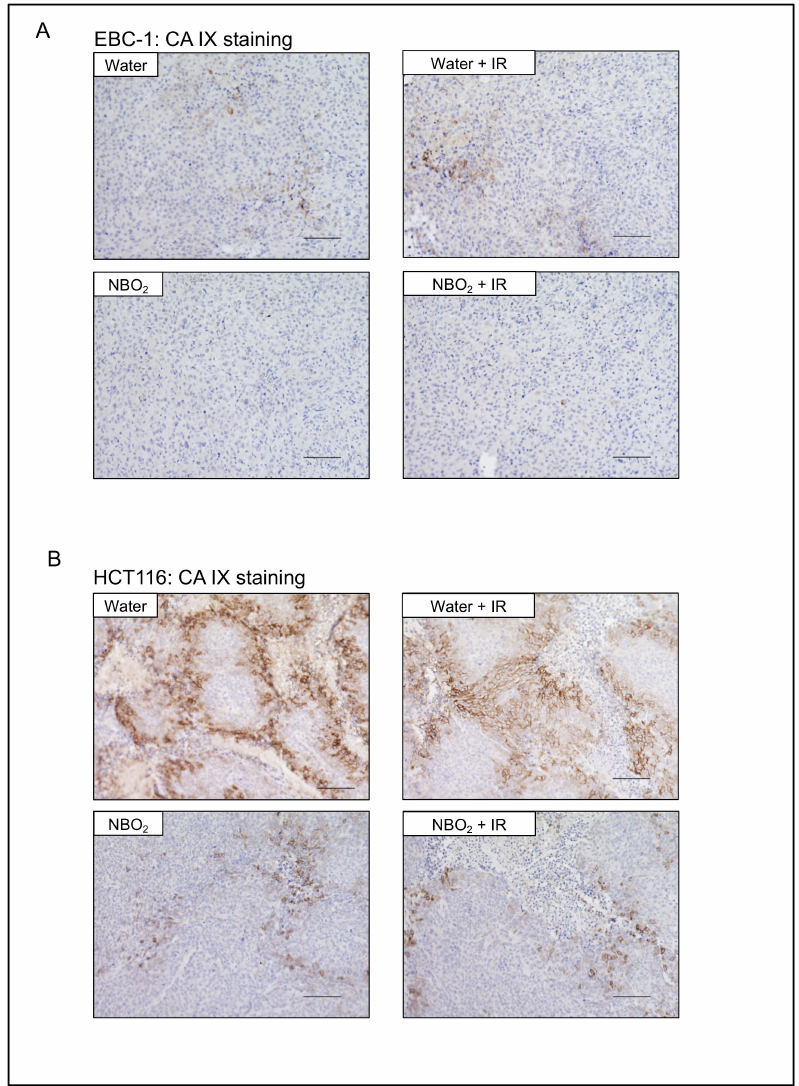
Figure 6. Hypoxia-related carbonic anhydrase IX (CA IX) expression in EBC-1 and HCT116 xenografted tumors of each treatment group. ( A , B ) Representative immunohistochemical stain- ing of CA IX in EBC-1 and HCT116 xenografted tumors of each group (scale bar 100 µ